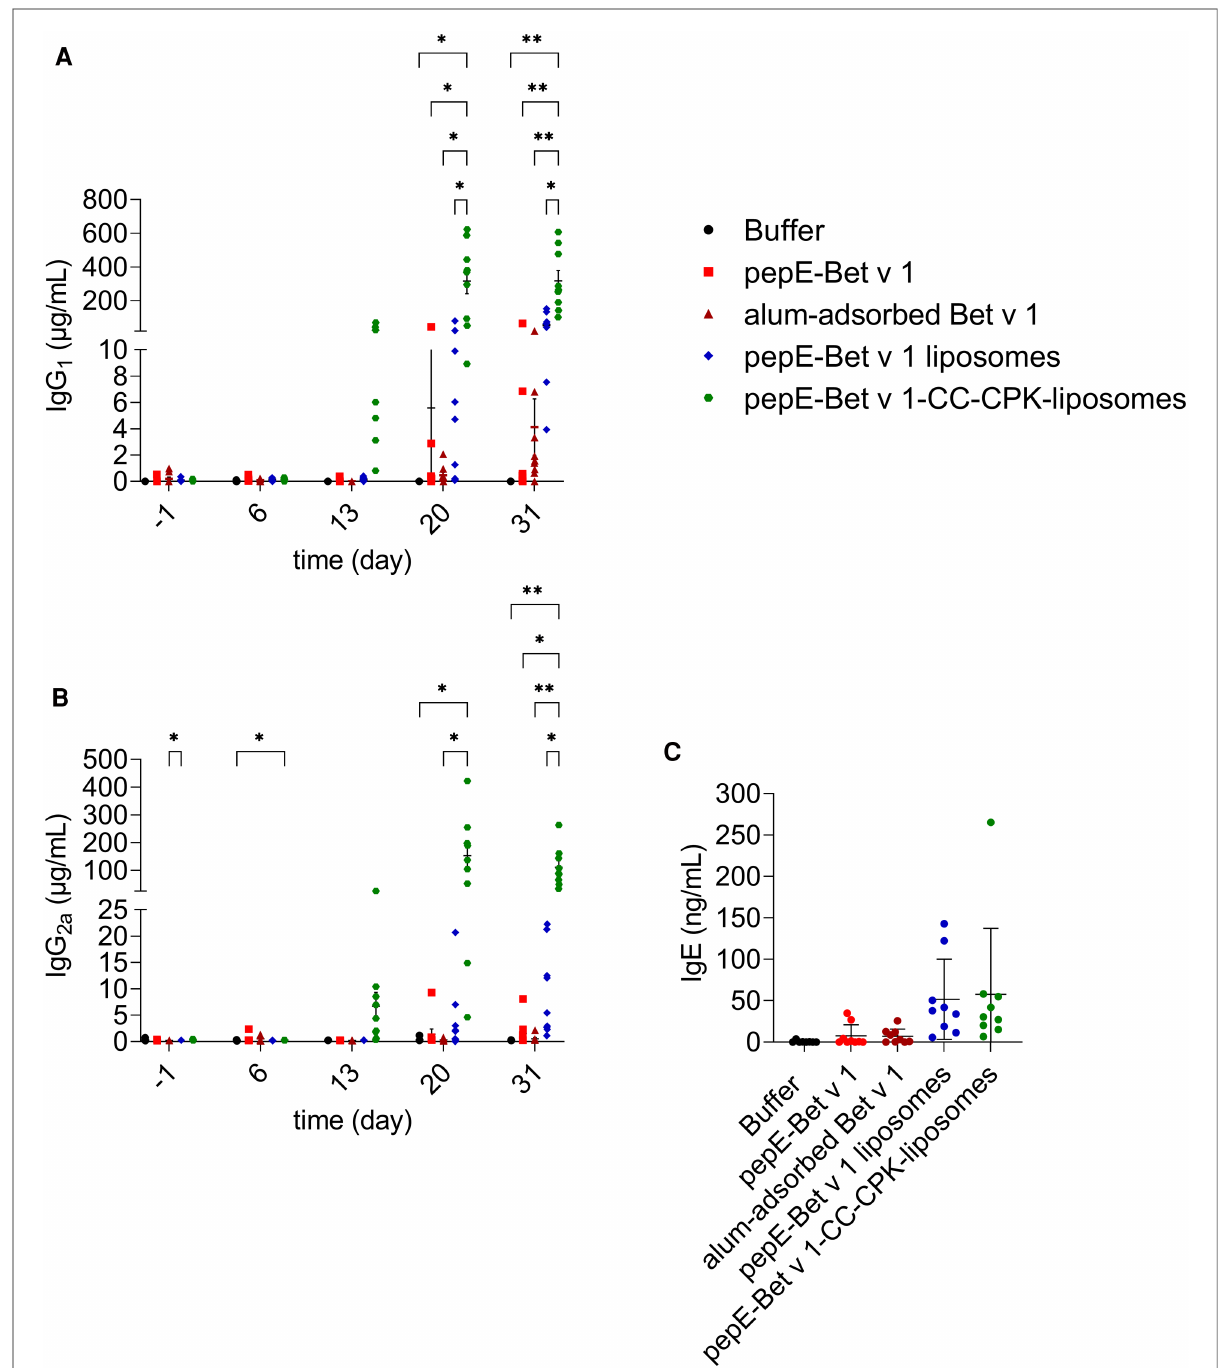
FIGURE 4 Murine immunogenicity. Mice ( n =9) were immunized with various formulations on day 0, 7 and 14 and received an intranasal challenge on day 27, 28 and 29 with birch pollen extract prior to the sacri fi ce (day 31). Bet v 1-speci fi c IgG 1 ( A ), IgG 2a ( B ) and IgE ( C ) were measured in serum collected at day − 1, 6, 13, 20 and 31. Group mean differences were analyzed with two-way ANOVA (IgG) or one-way ANOVA (IgE) followed by Tukey ’ s multiple comparisons test. *= p <0.05, **= p